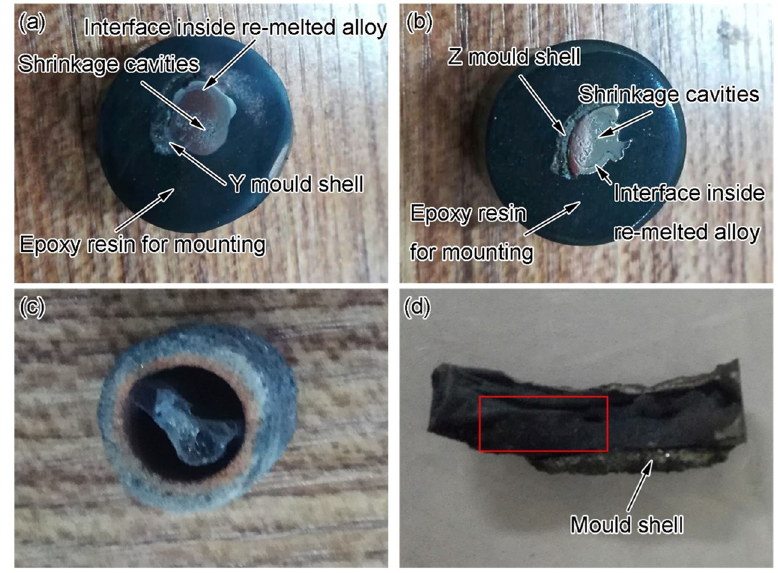
Figure 6. Macrophotographs of the samples after re-melting at 1850 °C for 30 min in a vacuum furnace with a graphite heating element: ( a ) cross section of the Y sample, ( b ) cross section of the Z sample, ( c ) untreated primitive Y sample and ( d ) lateral surface of the re-melted alloy in the Y mold shell.